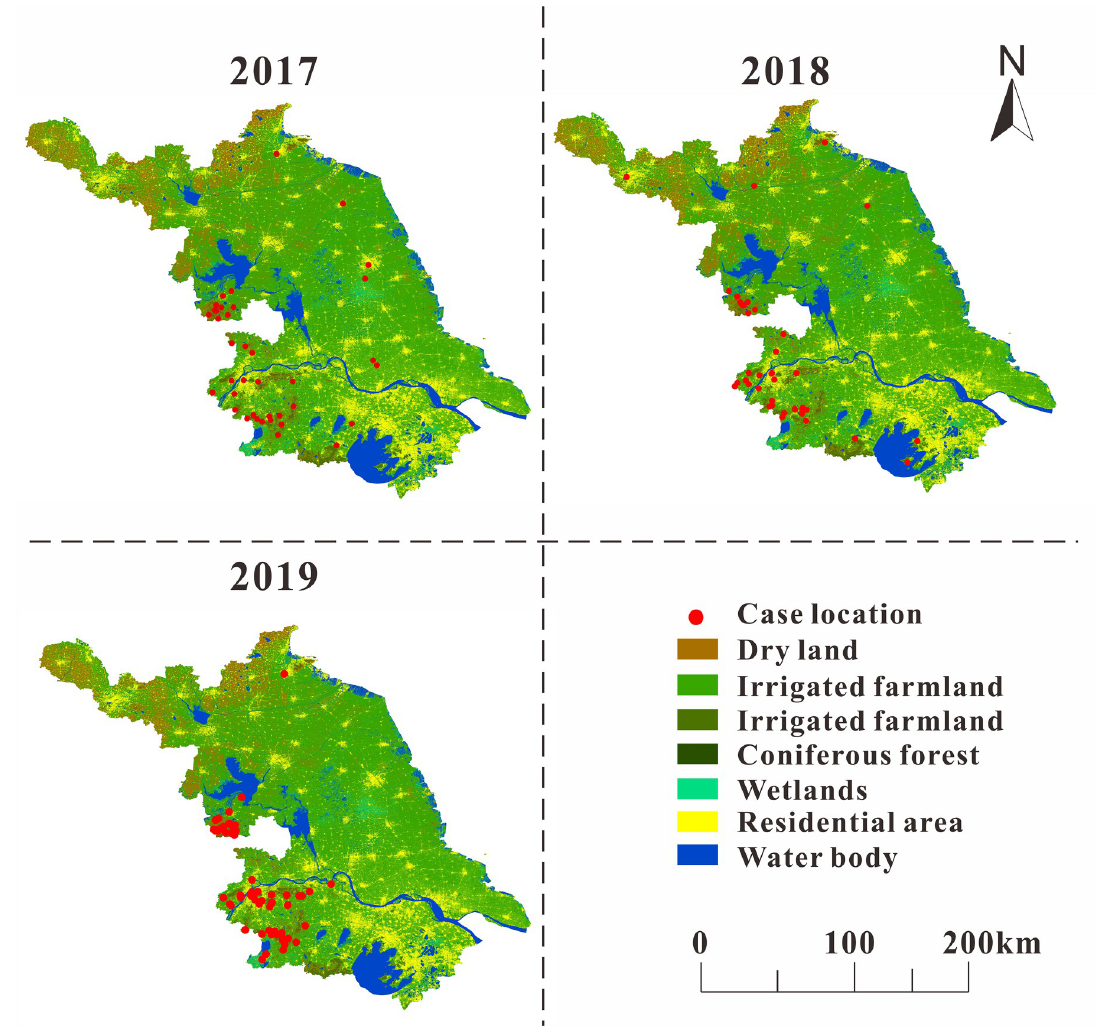
Fig 2. Land use map of each SFTS case location in Jiangsu Province from 2017 to 2019. http://www.globallandcover.com/defaults. html?type=data&src=/Scripts/map/defaults/browse.html&head=browse&type=data (Map source).